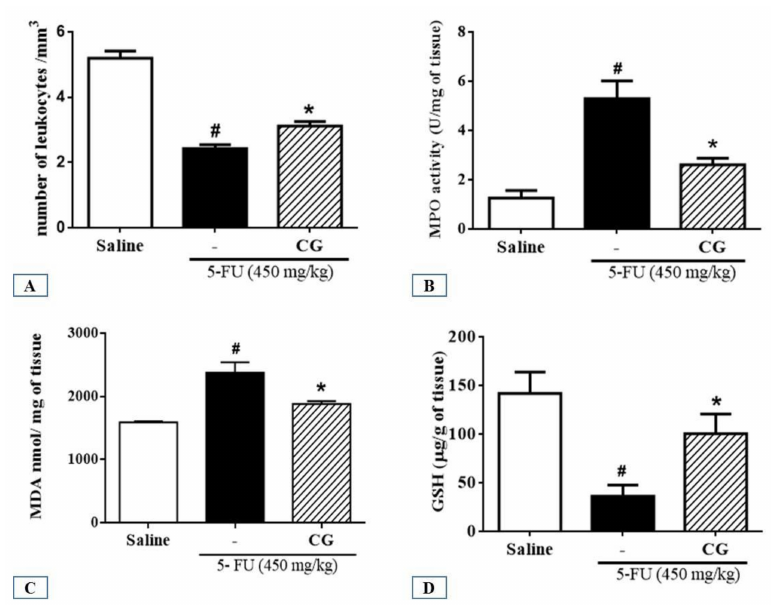
Figure 3. ( A ) Total leukocyte count; ( B ) Activity of myeloperoxidase (MPO); ( C ) Level of malondialdehyde (MDA); ( D ) concentration of glutathione (GSH). Values were presented as mean ± SEM. For the statistical analysis, one-way ANOVA followed by Tukey’s test was used, where # p < 0.05 vs. saline group and * p < 0.05 vs. group